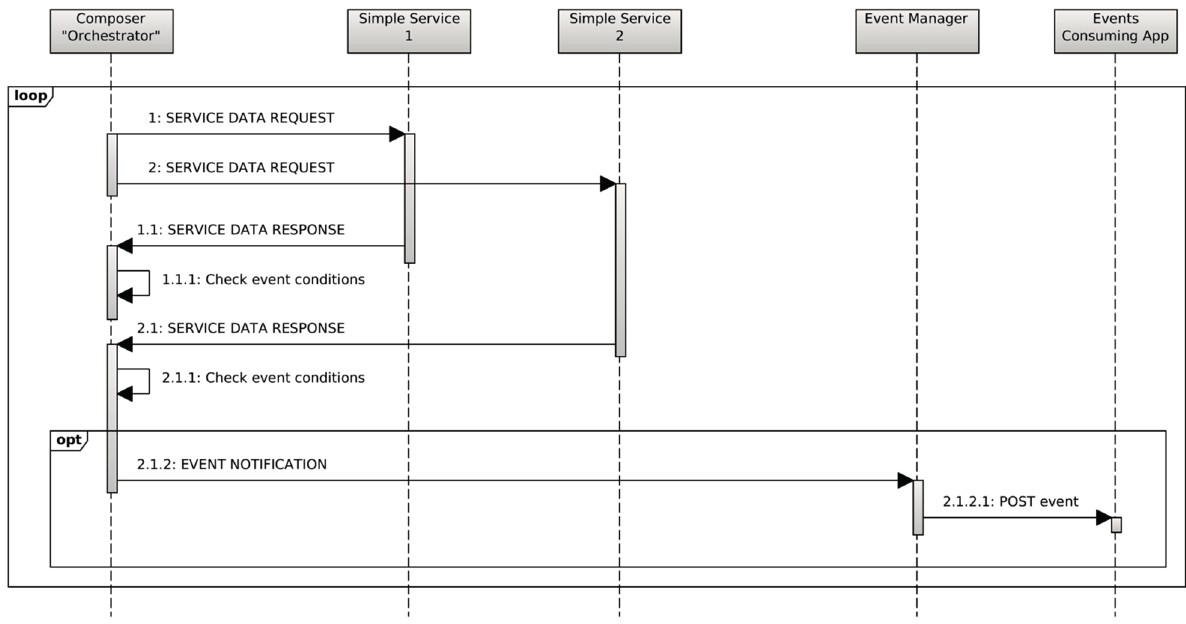
Figure 4. Event generation from a composed event